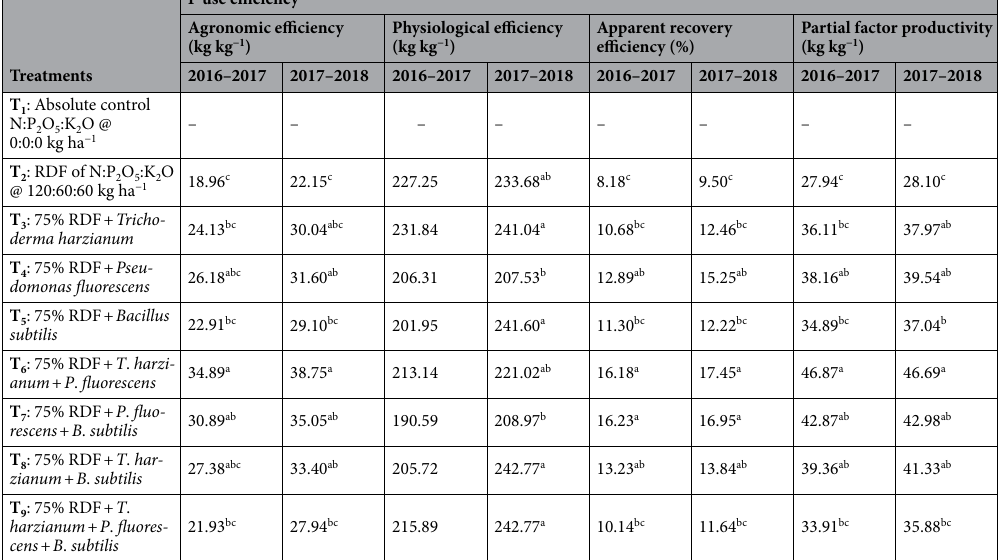
lowest N use efficiency, respectively. About 68% increase in PFP N was found in T 6 compared to 100% RDF (T 2 ). The effect of P . fluorescens on PFP N was higher than other single-species bio-priming agents. The results revealed that dual consortium treatments were more competent in converting the applied N into marketable yield. Our result was consistent with the observation of Chatterjee et al. 34 . Phosphorus use efficiency.